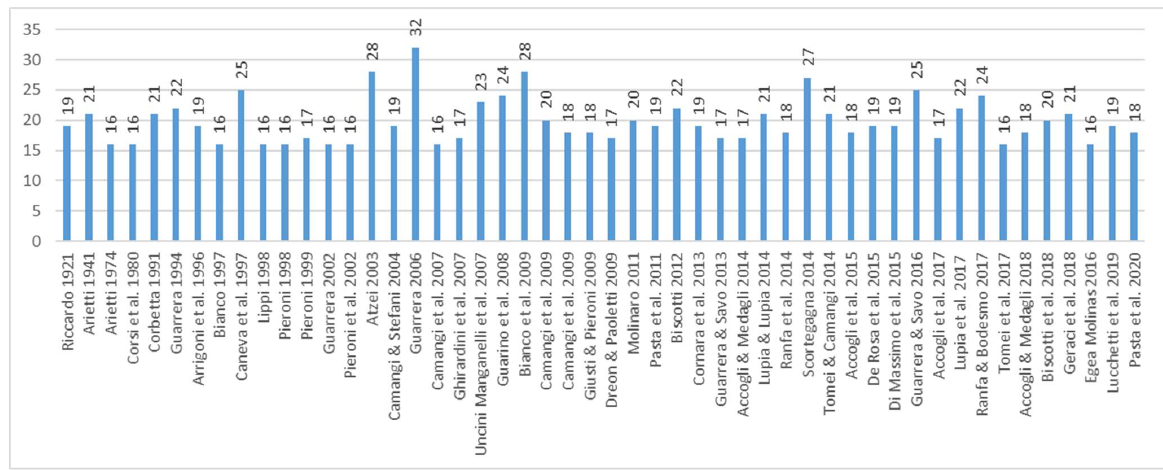
Figure 18. Number of taxa cited by [57] and also reported in publications of subsequent